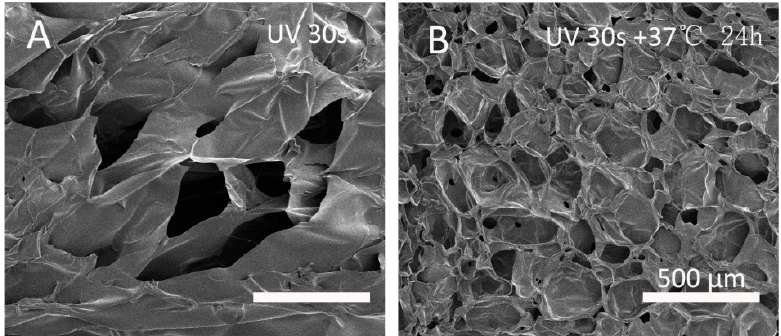
Figure 6. SEM of HA/PEG-III hydrogel formed via photo-crosslinking reaction and thermal-induced DA reaction. ( A ) only UV light 30 s; ( B ) UV 30 S, then 37 °C further reaction for 24 h. Scale bar: 500 μ m.